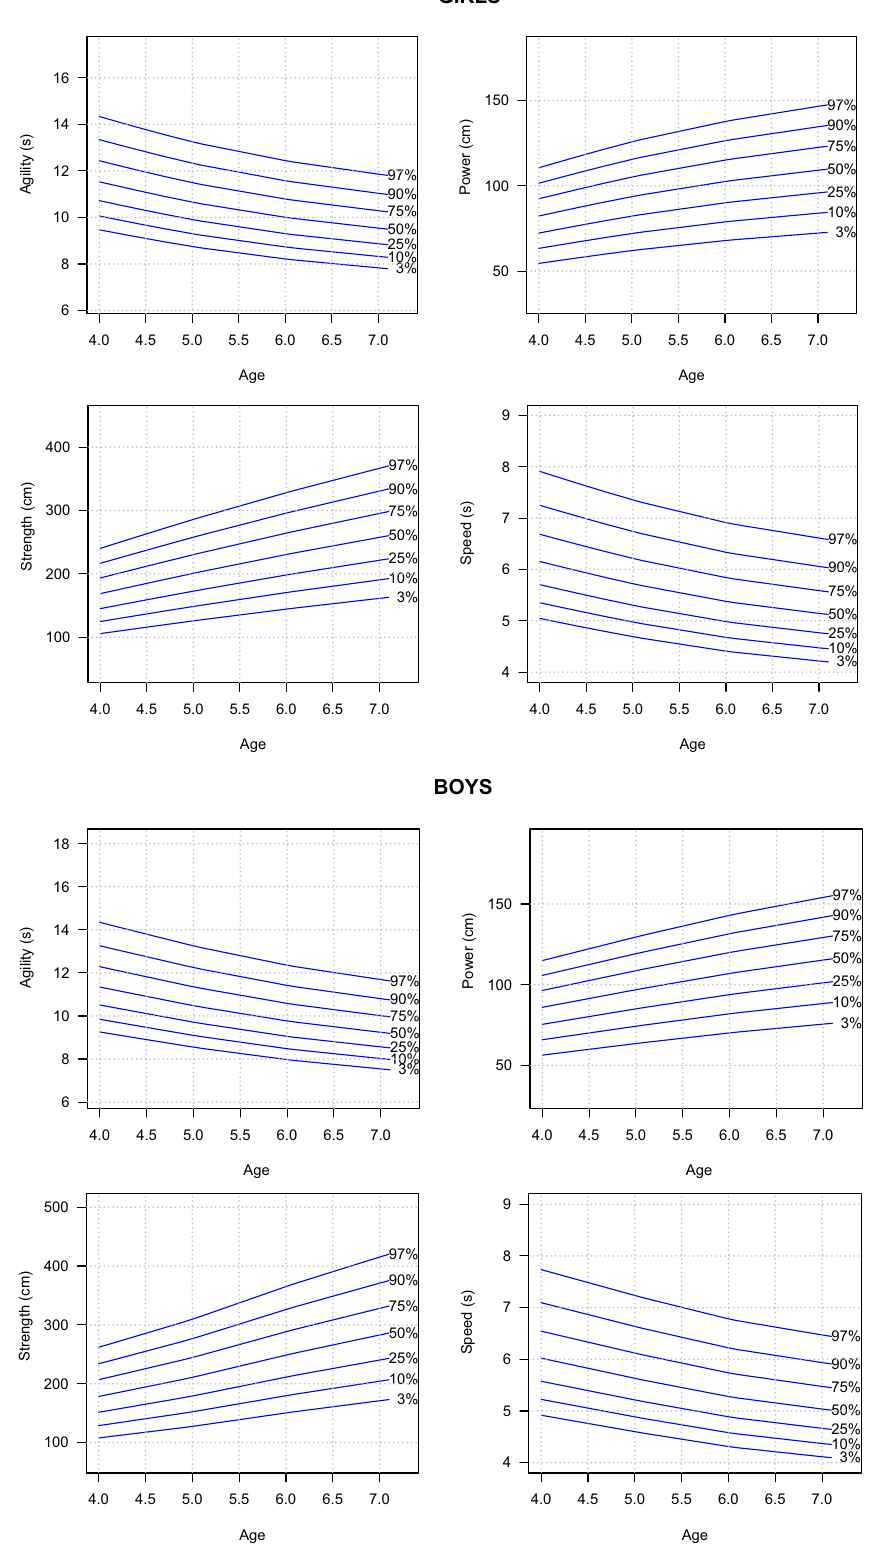
Figure 1. Percentiles charts of physical firness of Polish children aged 4–7